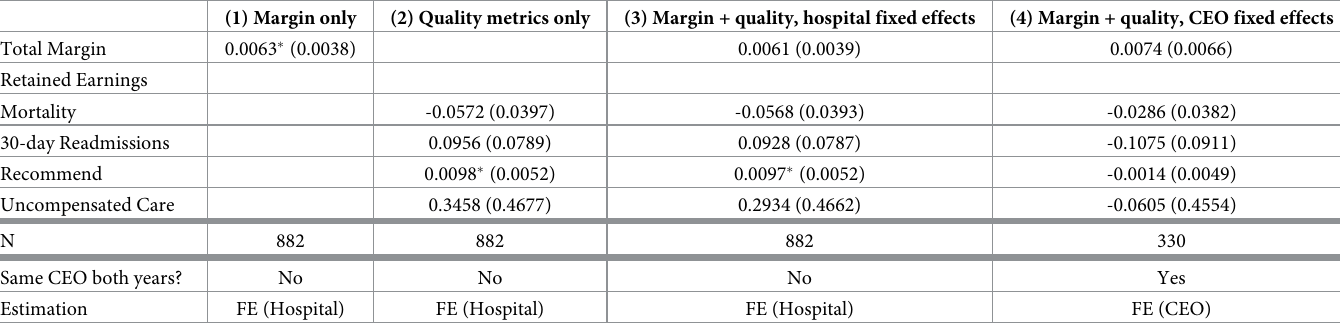
Table 2. Effect of hospital performance measures on CEO compensation (2010 & 2015 fixed effects regression